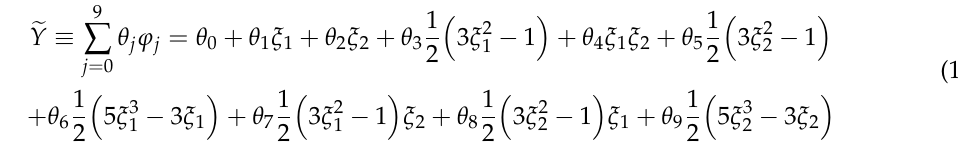
Table 1. Multivariate 2D Legendre polynomials for total polynomial order P = 3.